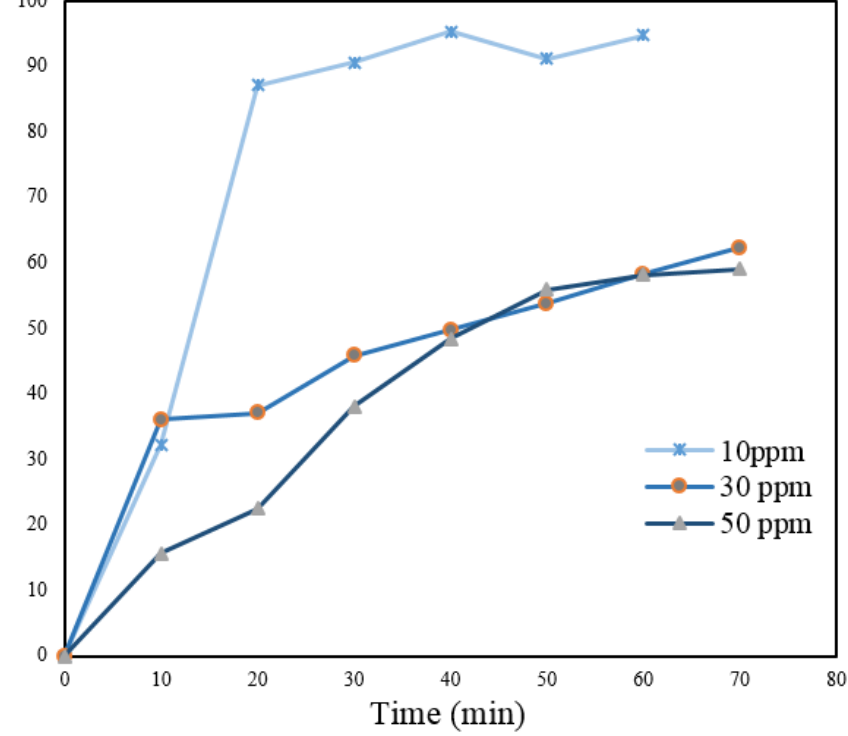
Fig. 14. Effect of dissolved concentration on degradation of methylene blue Fig (14): Diagram of the effect of dissolved concentration on the degradation of methylene blue dye.